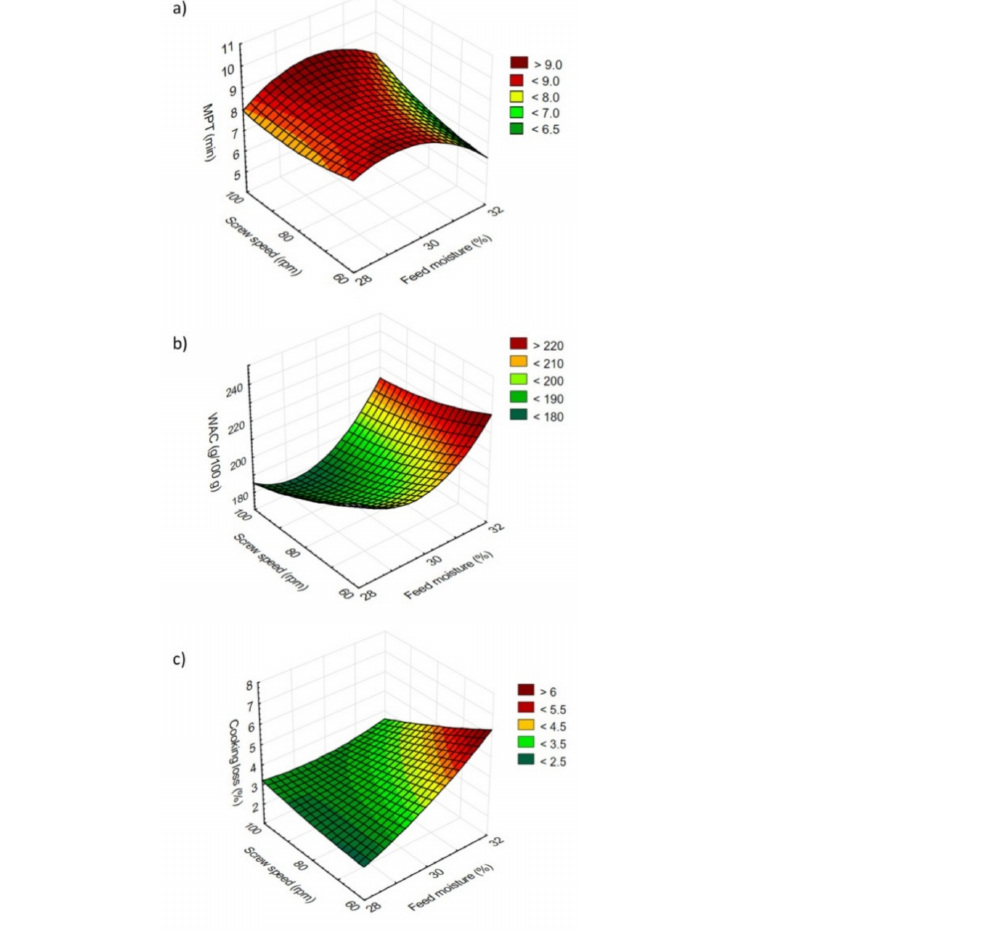
Figure 1. Minimum preparation time (MPT) ( a ), water absorption capacity (WAC) ( b ), and cooking loss ( c ) as affected by feed moisture and screw speed during the processing of rice